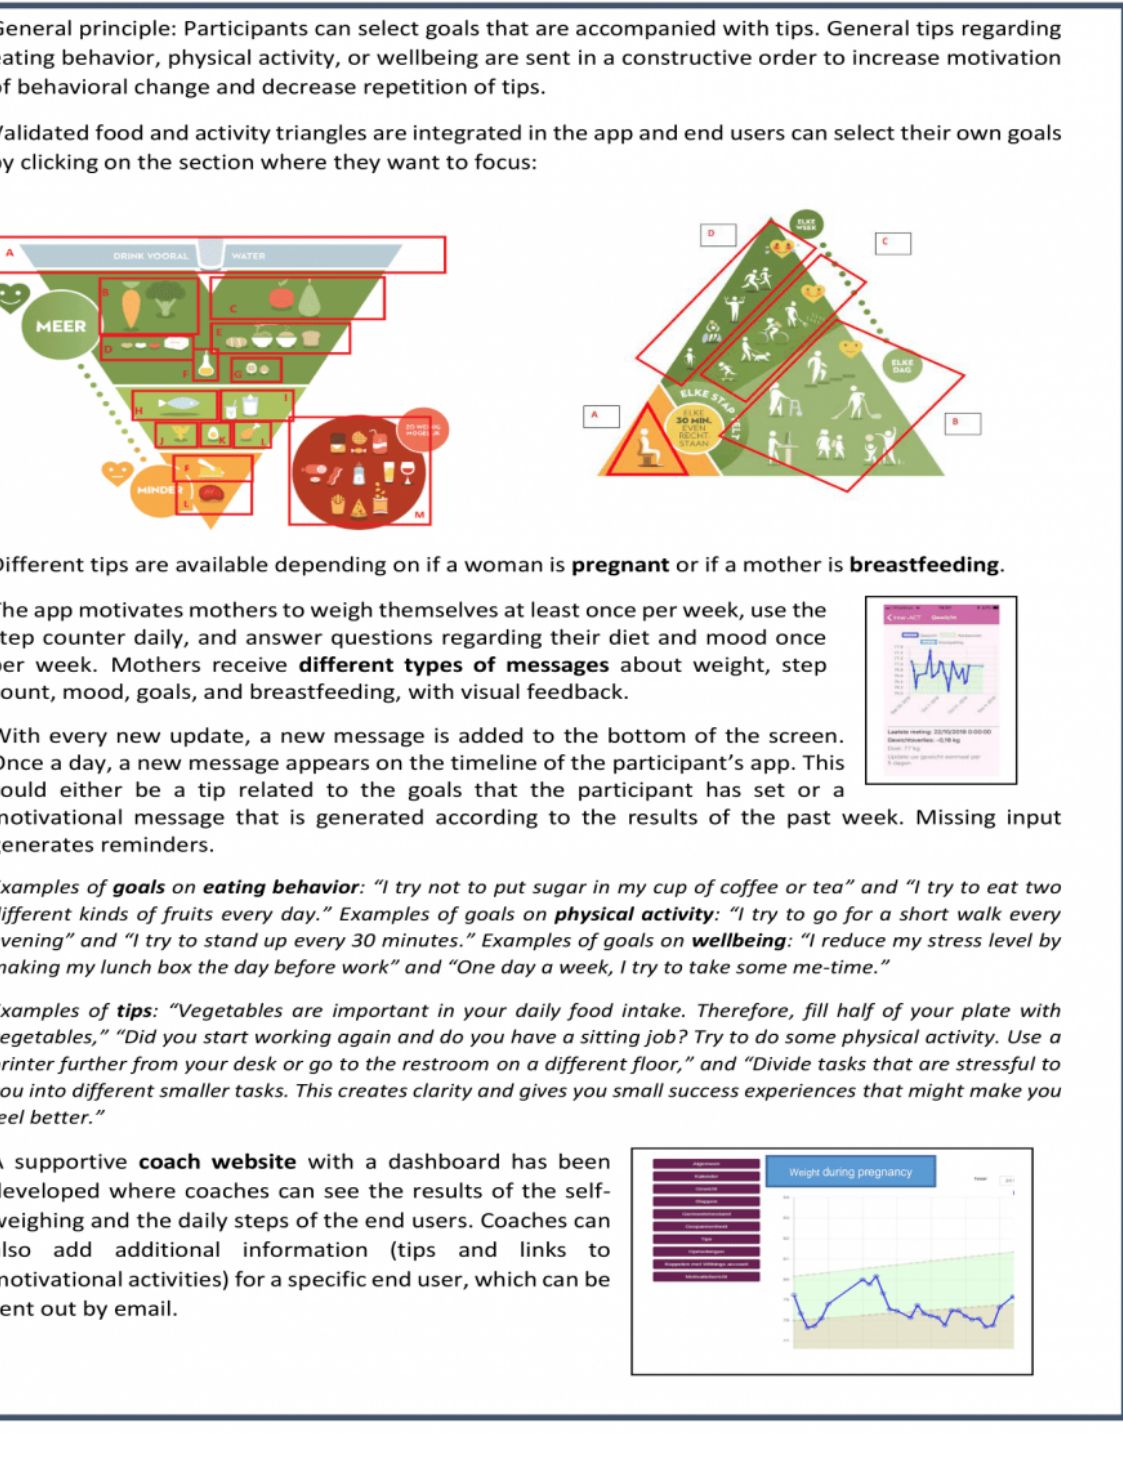
Figure 2. Description of the functionality of the INTER-ACT app and examples of